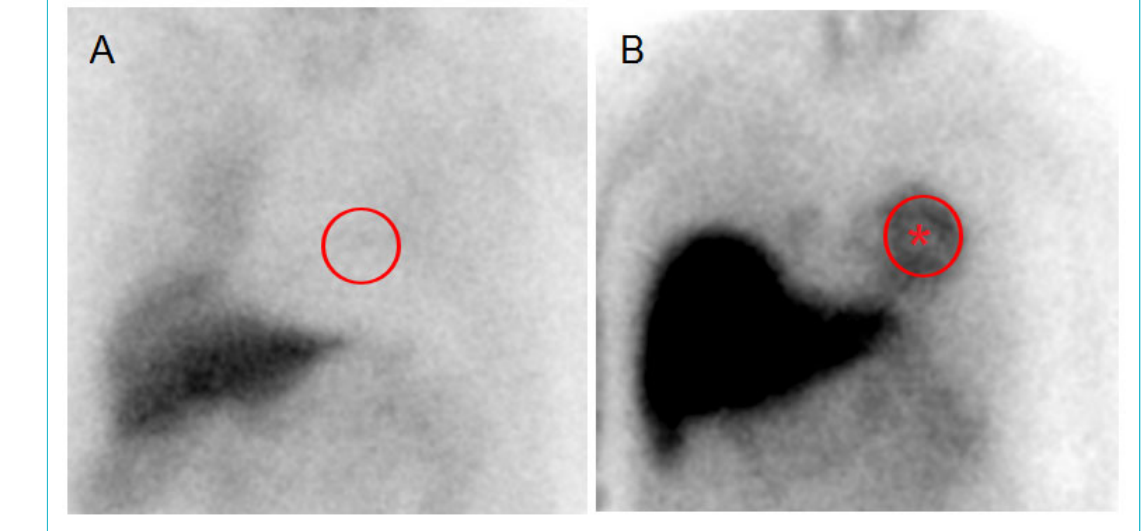
Figure 3: Heart planar 123 I-MIBG scintigraphy 4 hours post-injection showing absent (A) heart visualisation (red circle), compatible with Parkinson’s disease. In B, heart visualisation is preserved (red star), as it is in atypical degenerative parkinsonian